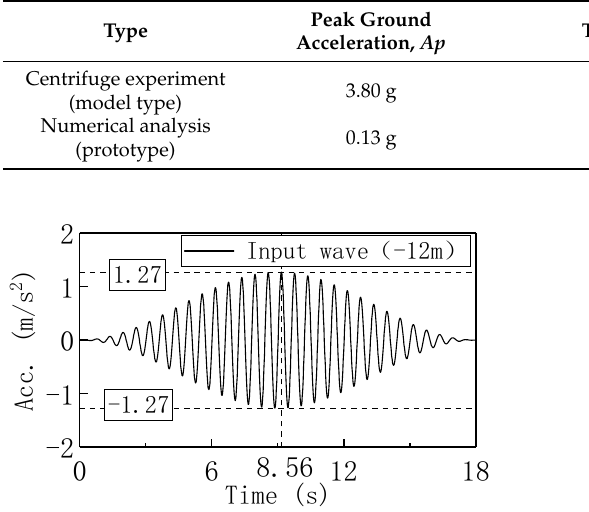
Table 2. Input dynamic wave in model type and prototype (satisfying scaling law).